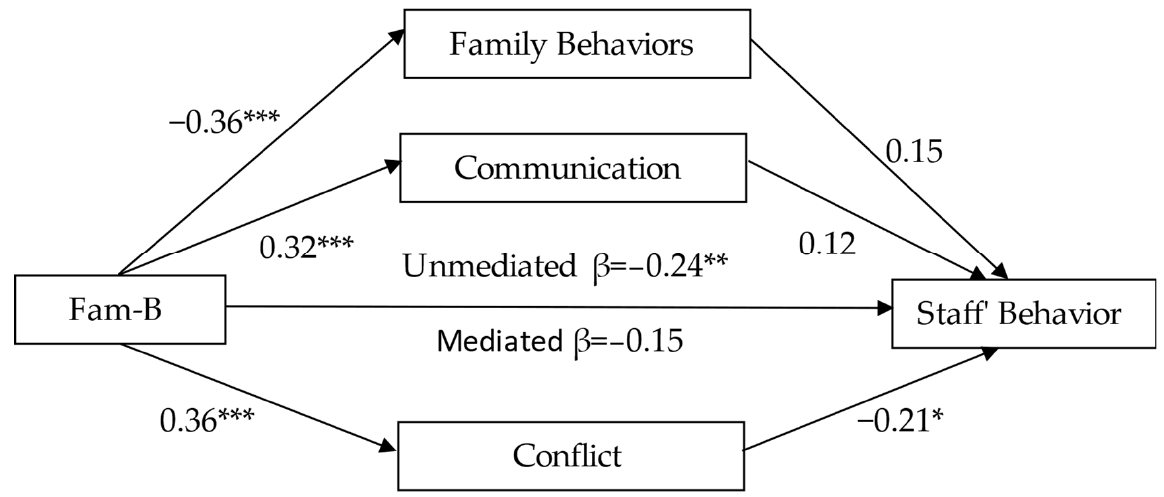
Figure 2. A multiple mediation model of Fam-B and staff behavior through interaction variables